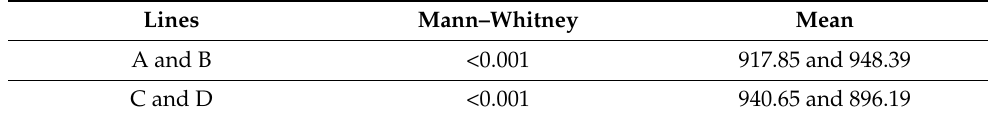
Table 6. Mann–Whitney results without outliers.